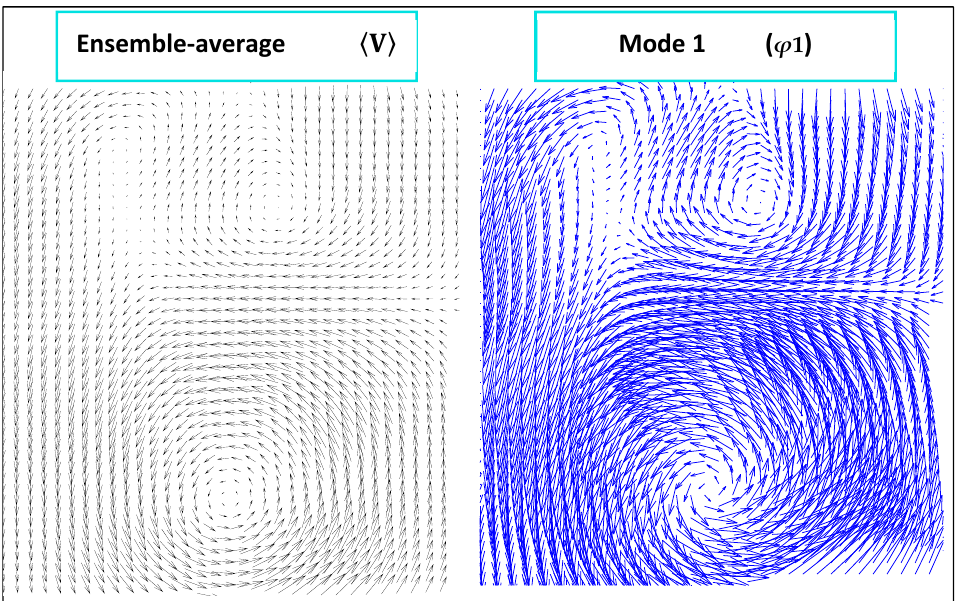
Figure 9. Ensemble average 〈V〉 and mode 1 ( φ 1) spatial structures without subtracting the mean Figure 9. Ensemble average (cid:104) V (cid:105) and mode 1 ( ϕ 1) spatial structures without subtracting the mean prior prior performing POD. performing POD. Table 1. Kinetic energy comparison of POD and Reynolds decomposition with and without subtracting the ensemble